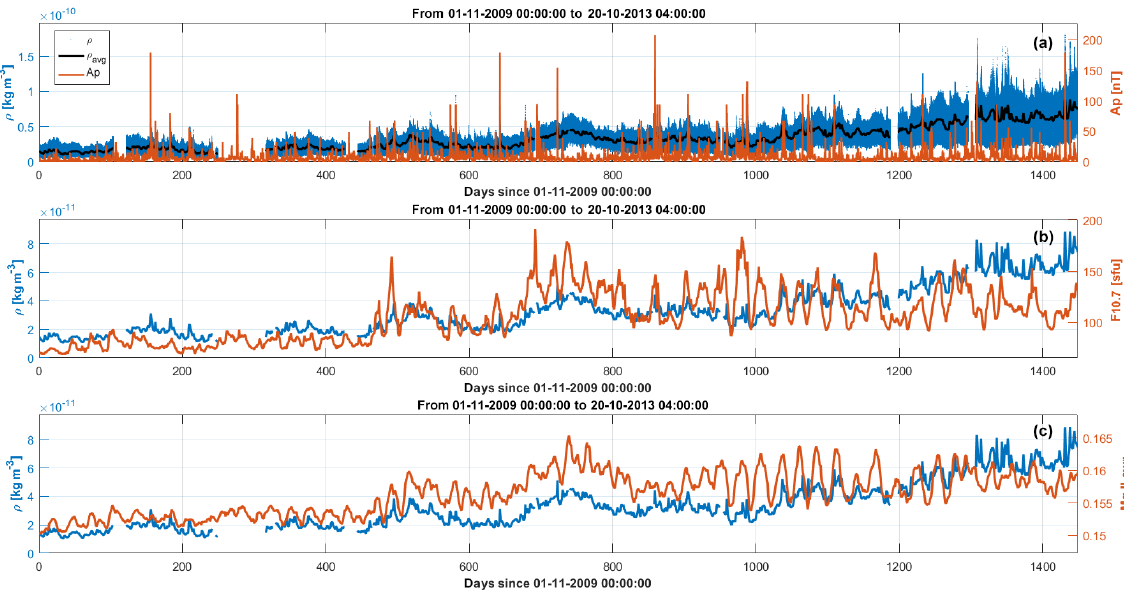
Figure 5. Comparison of time series for whole-mission thermospheric-density and solar indices Ap, F10.7 and Mg II. (a) Density (full dataset, blue line; daily averaged, black line) with the Ap index (red line). (b, c) Daily averaged density (blue) and F10.7 and Mg II indices (red), respectively. Solar flux unit: